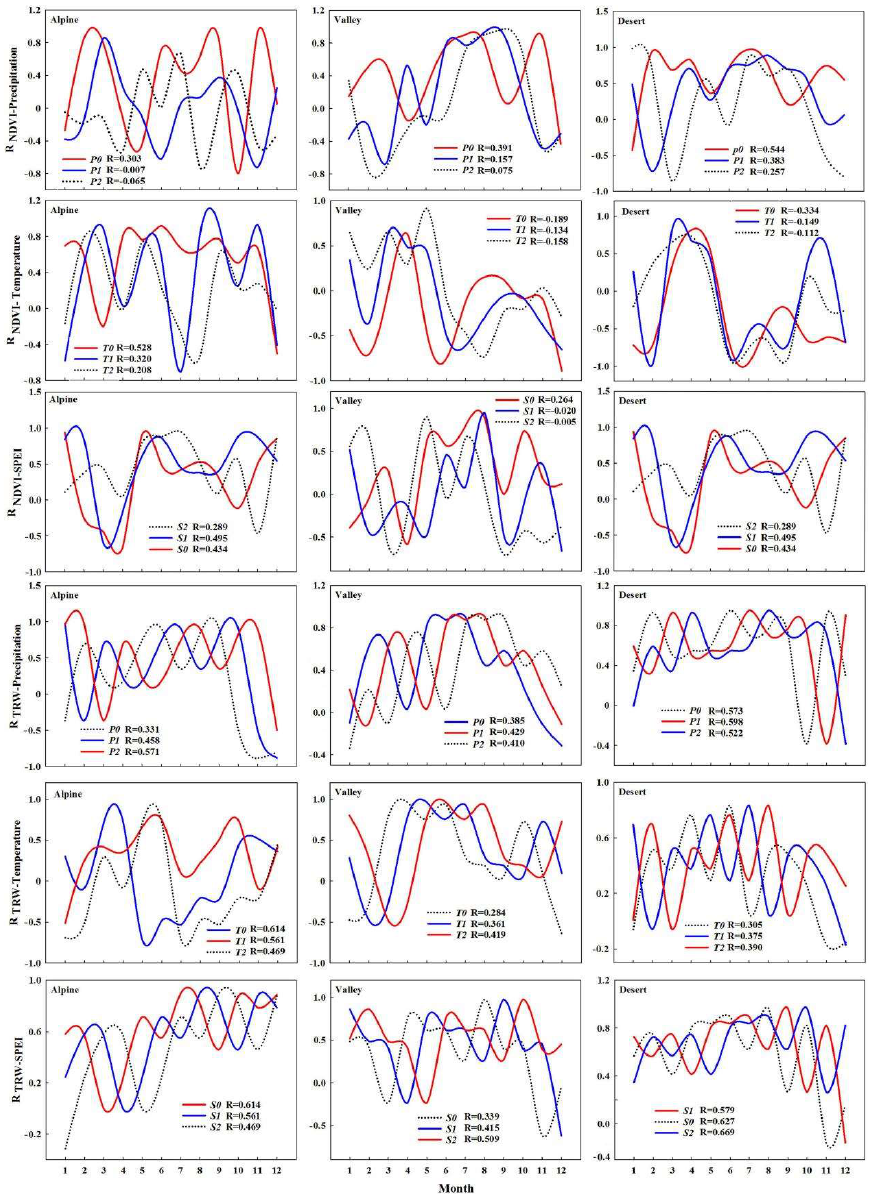
Figure 9. Hysteresis effects of NDVI, TRW on climate factors. Note: T0 , T1 and T2 represent the temperature of the current month, the temperature of the previous month and the temperature of the previous 2 months, respectively. P0 , P1 and P2 indicate the precipitation of the current month, the precipitation of the previous month and the precipitation of the previous 2 months, respectively. S0 , S1 and S2 indicate the SPEI of the current month, the SPEI of the previous month and the SPEI of the previous 2 months, respectively.